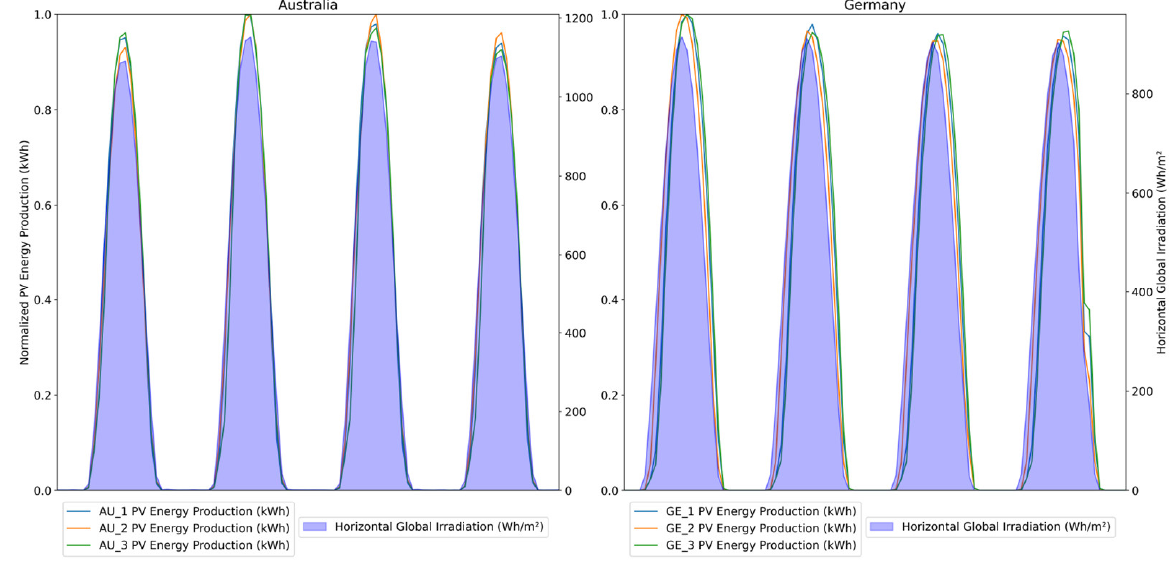
Figure 7. Normalized PV energy production and horizontal solar irradiation for the facilities from Germany and Australia during a four-day period.